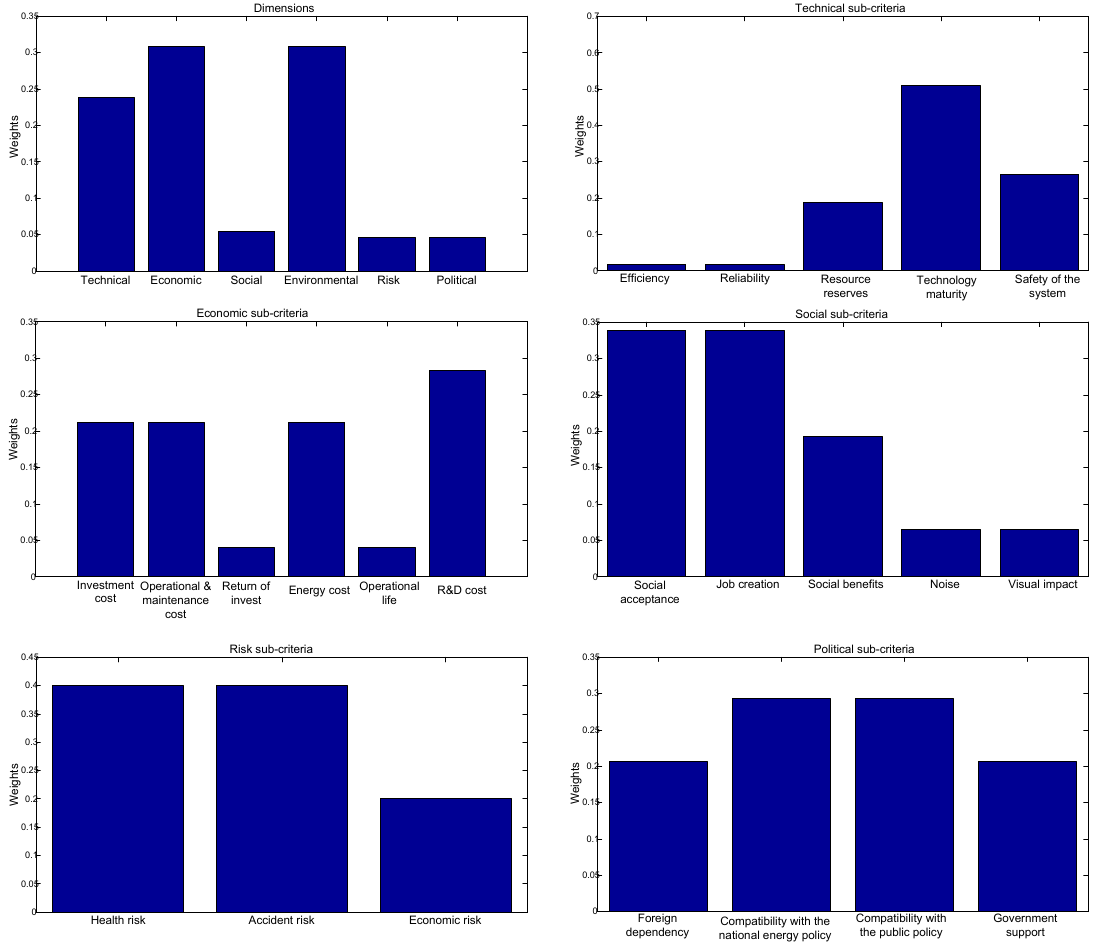
Figure 2. Results of modified M-BO and M-OW vectors of the dimensions/sub-criteria.